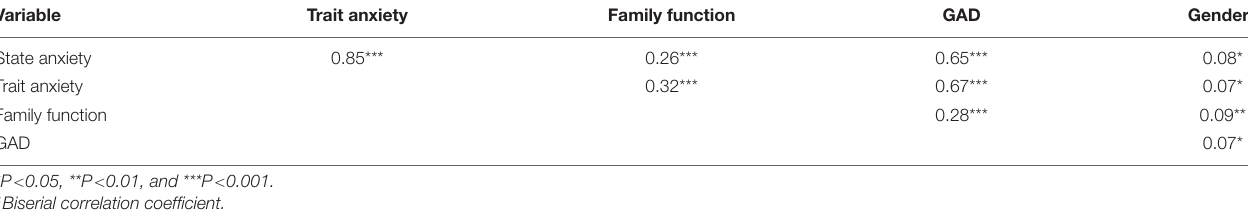
TABLE 4 | The results of Pearson correlation analysis among gender, state anxiety, trait anxiety, family function, and GAD. Variable